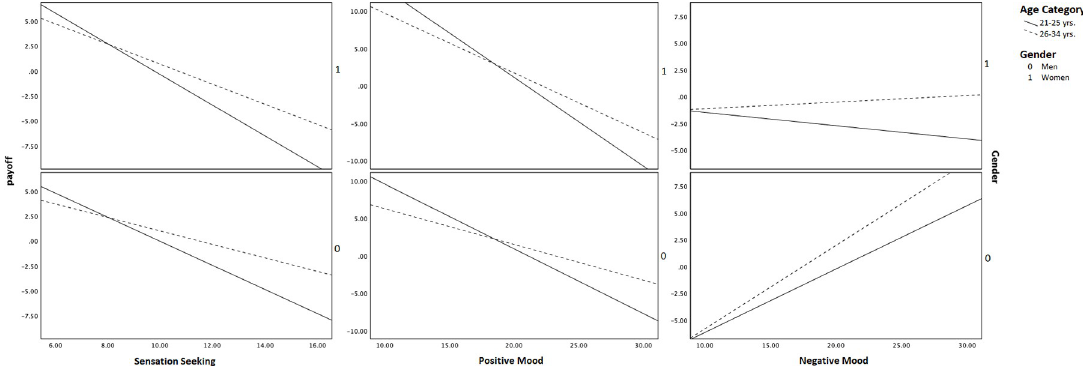
Fig 3. Conditional relationship in mediation-moderation model